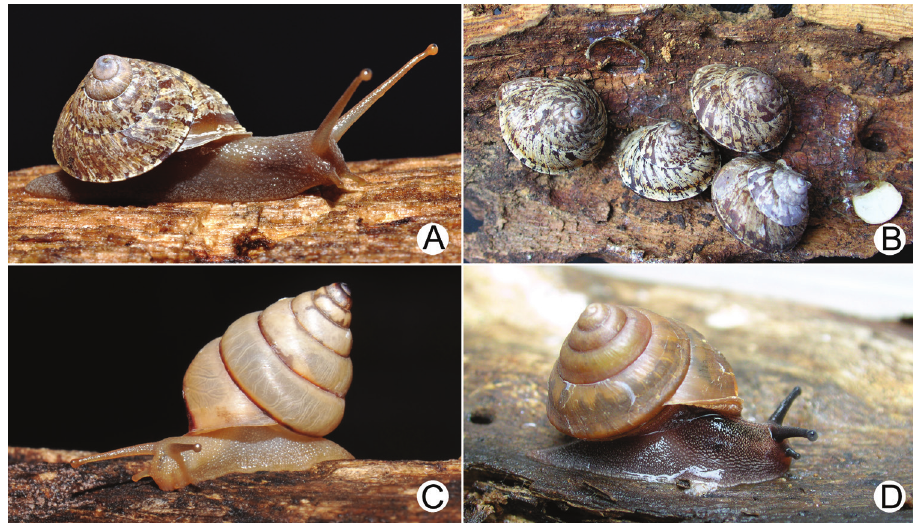
Figure 1. A, B Ganesella carinella from Keng-khoy, Saraburi (shell width about 15 mm) A live snail and B snails aestivated under loose tree bark, and with white epiphrams attached on substrate C Ganesella rhombostoma from Klong Had, Srakeo (shell height about 15 mm) D Globotrochus onestera from Cuc Phuong, Vietnam (shell width about 15